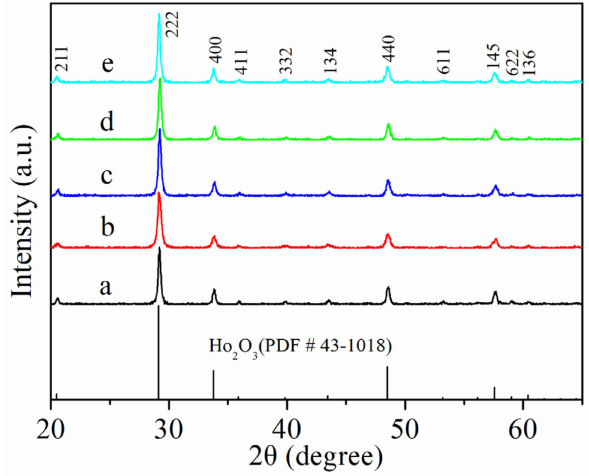
Figure 4. XRD patterns of the catalysts. (a) Ho 2 O 3 -NP, (b) Ho 2 O 3 -NS, (c) 0.02Sr-Ho 2 O 3 -NS, (d) 0.04Sr-